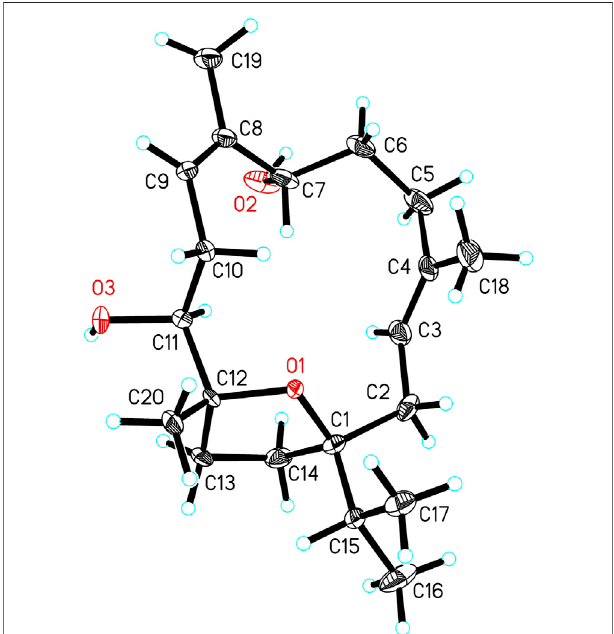
FIGURE 4 | X-ray ORTEP drawing of compound 1 .